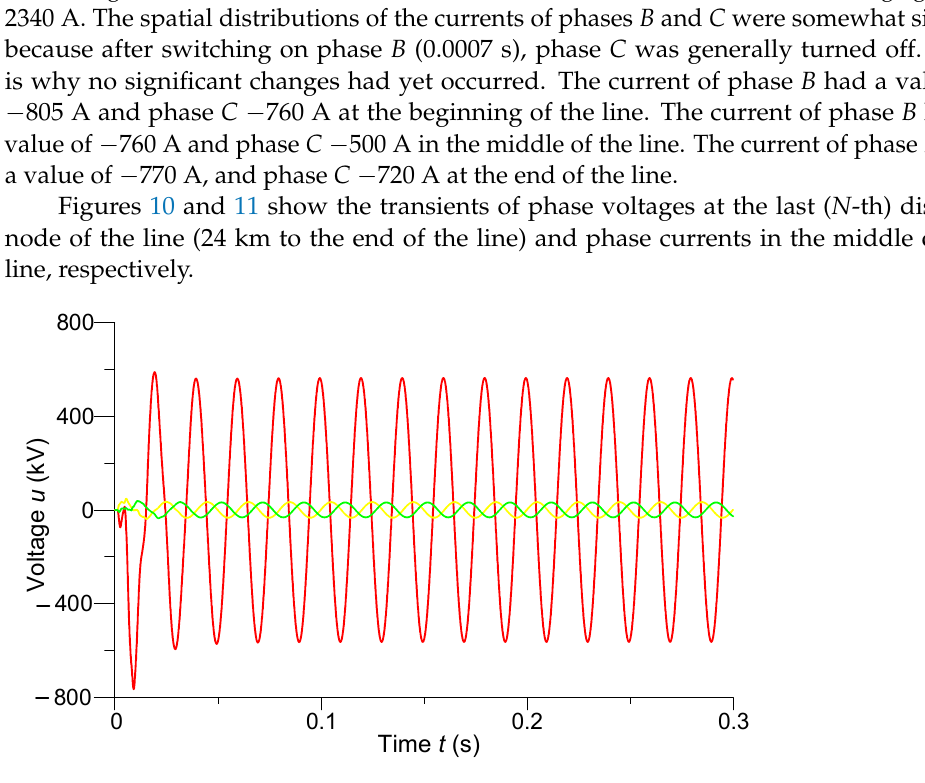
Figure 10. Transient processes of phase voltages on the last discrete node of the line (24 km to the end of the line).